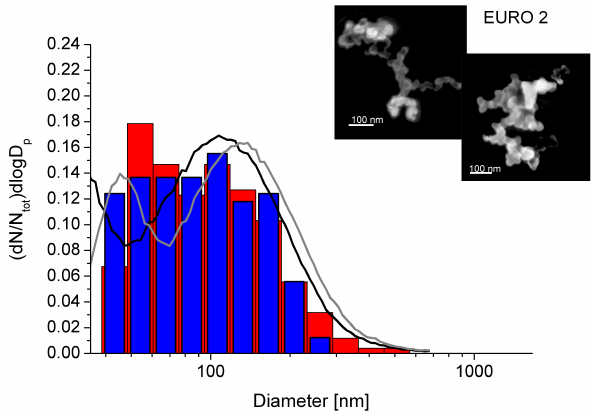
Fig. 3. Size distributions measured using SEM images and the SMPS shown in bars and lines. Blue and red bars, black and grey lines illustrate the fresh and aged particles. The projected area diam- eter of the illustrated soot particles are 220nm for the fresh particle (left) and 390nm for the aged soot particle (right).